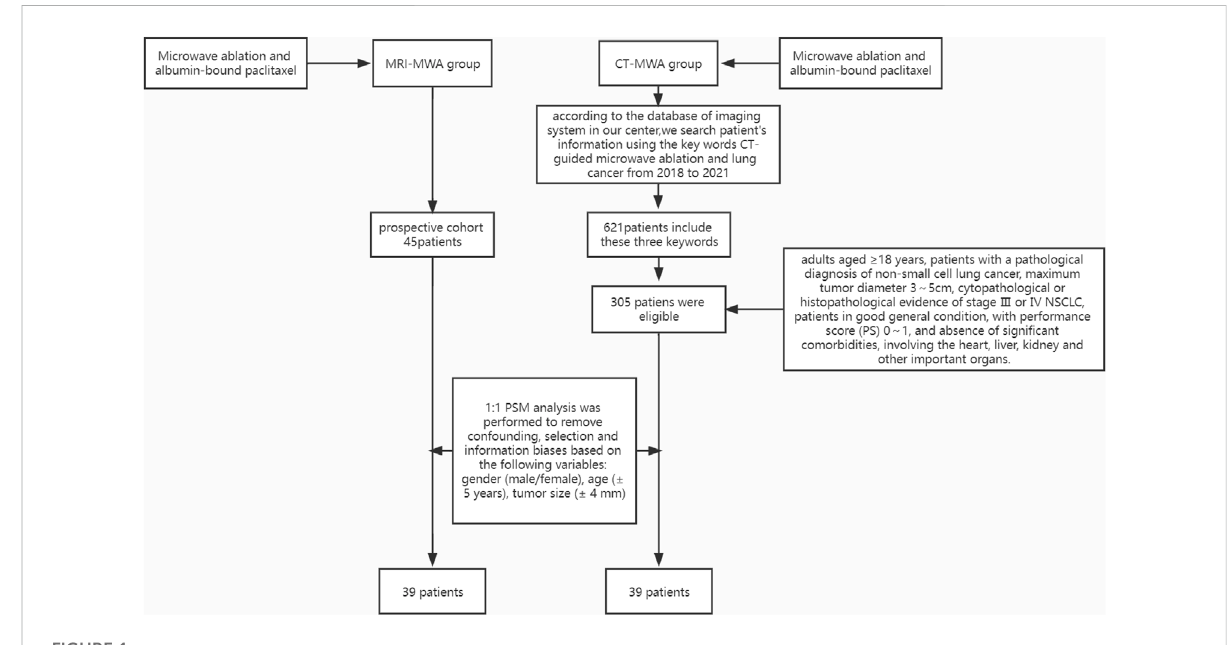
FIGURE 1 Screening process for eligible patients.